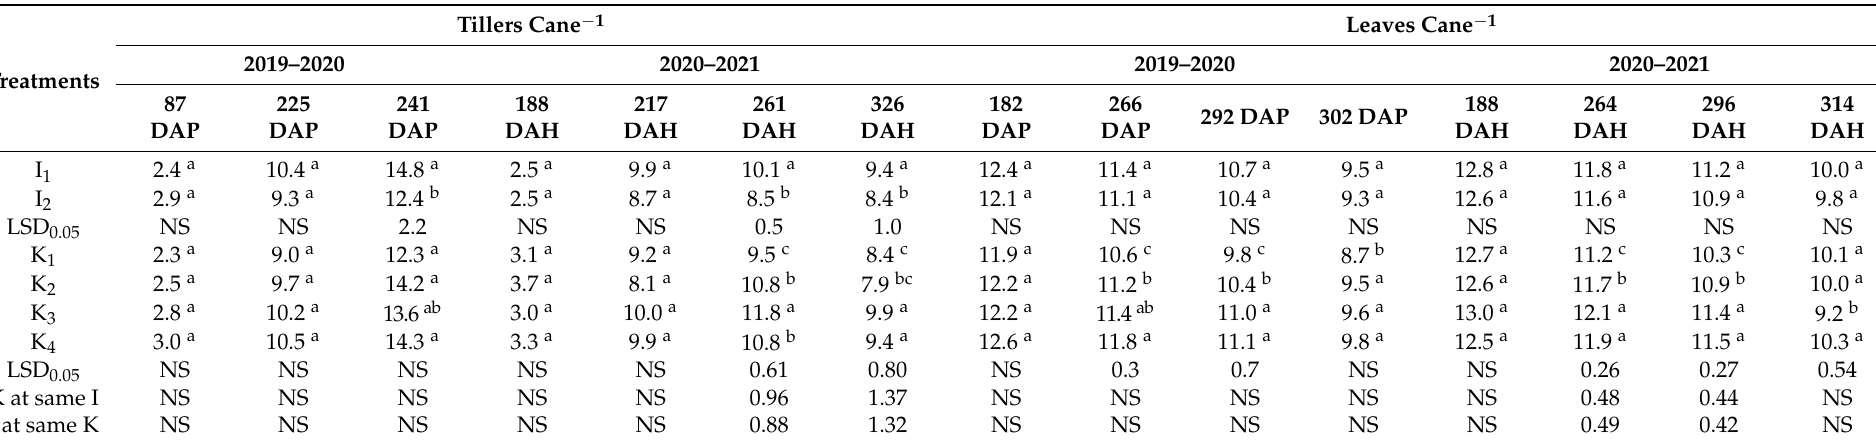
Table 4. Sugarcane tillers and leaves as a function of irrigation and potash levels.